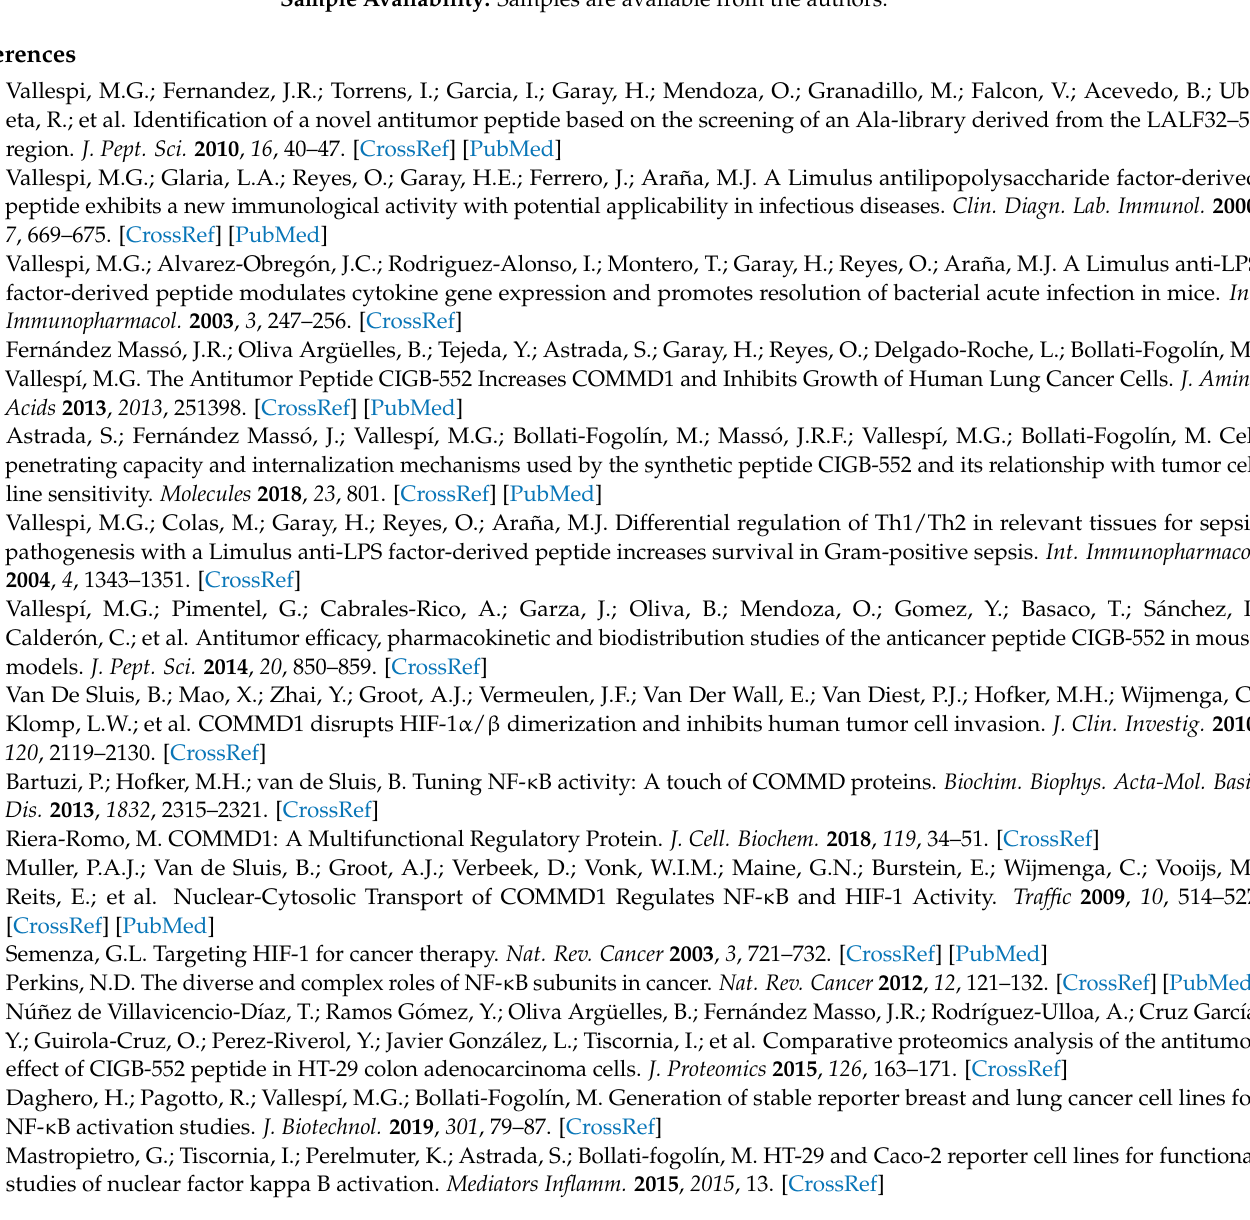
Figure S2. Gating strategy used for flow cytometry analysis of NF-kB